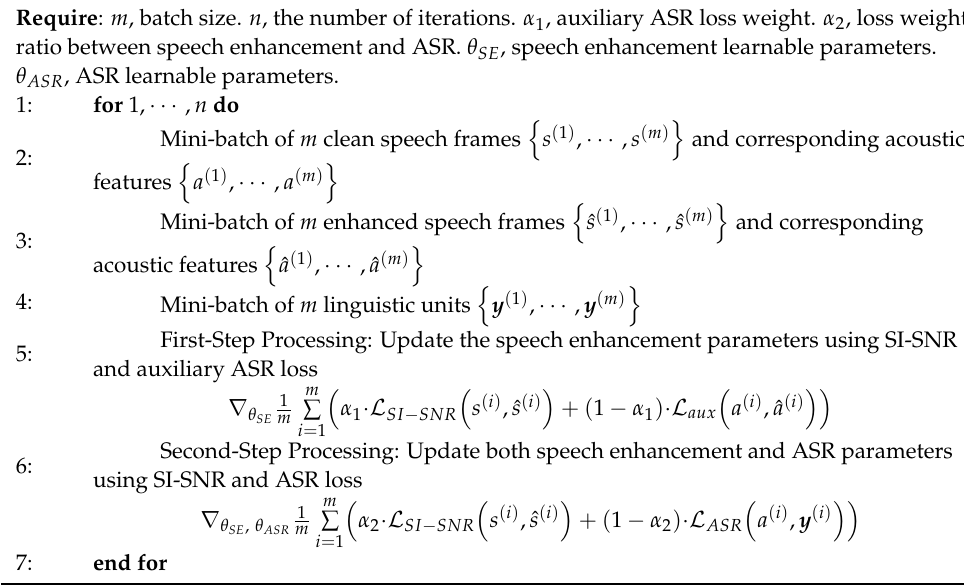
Algorithm 1: Two-Step Joint Optimization Procedure with Auxiliary ASR Loss.